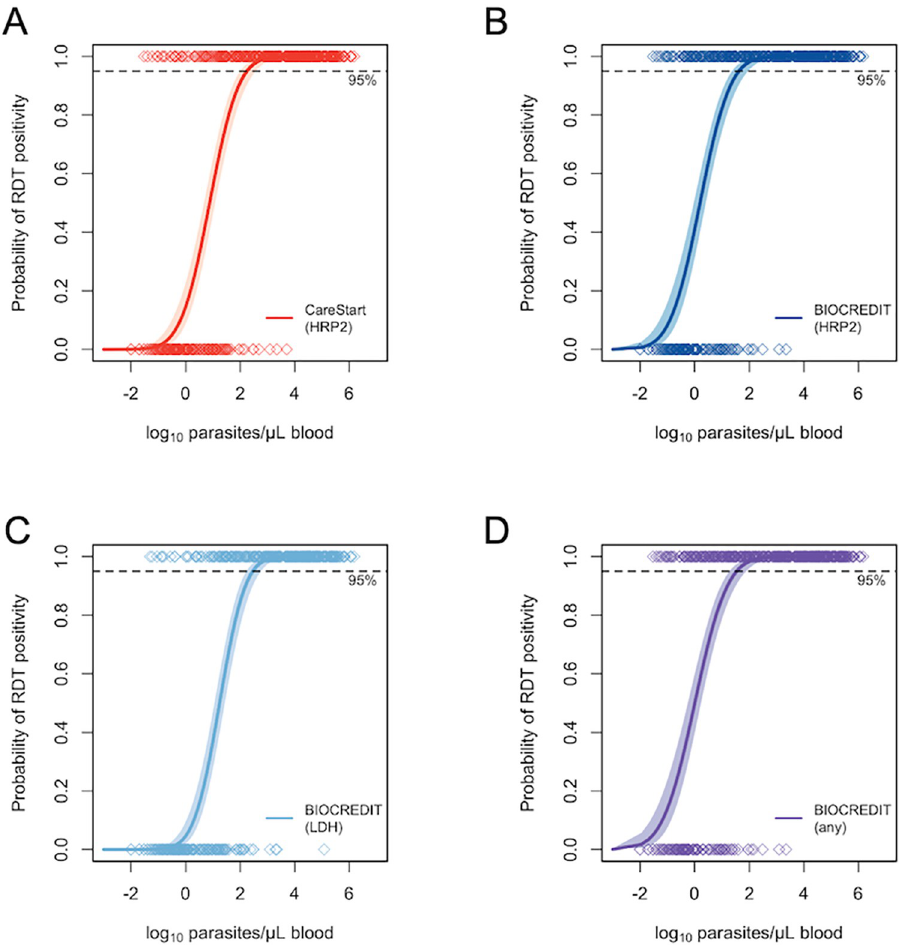
Fig 2. Limit of Detection (LoD) of each RDT and RDT target in relation to parasite density. Parasite density (by qPCR) of RDT positive and RDT negative samples is shown along the top and bottom X-axis. Shaded lines show 95% confidence intervals. A) Biocredit (any band) B) Biocredit HRP2 C) Biocredit LDH D) CareStart